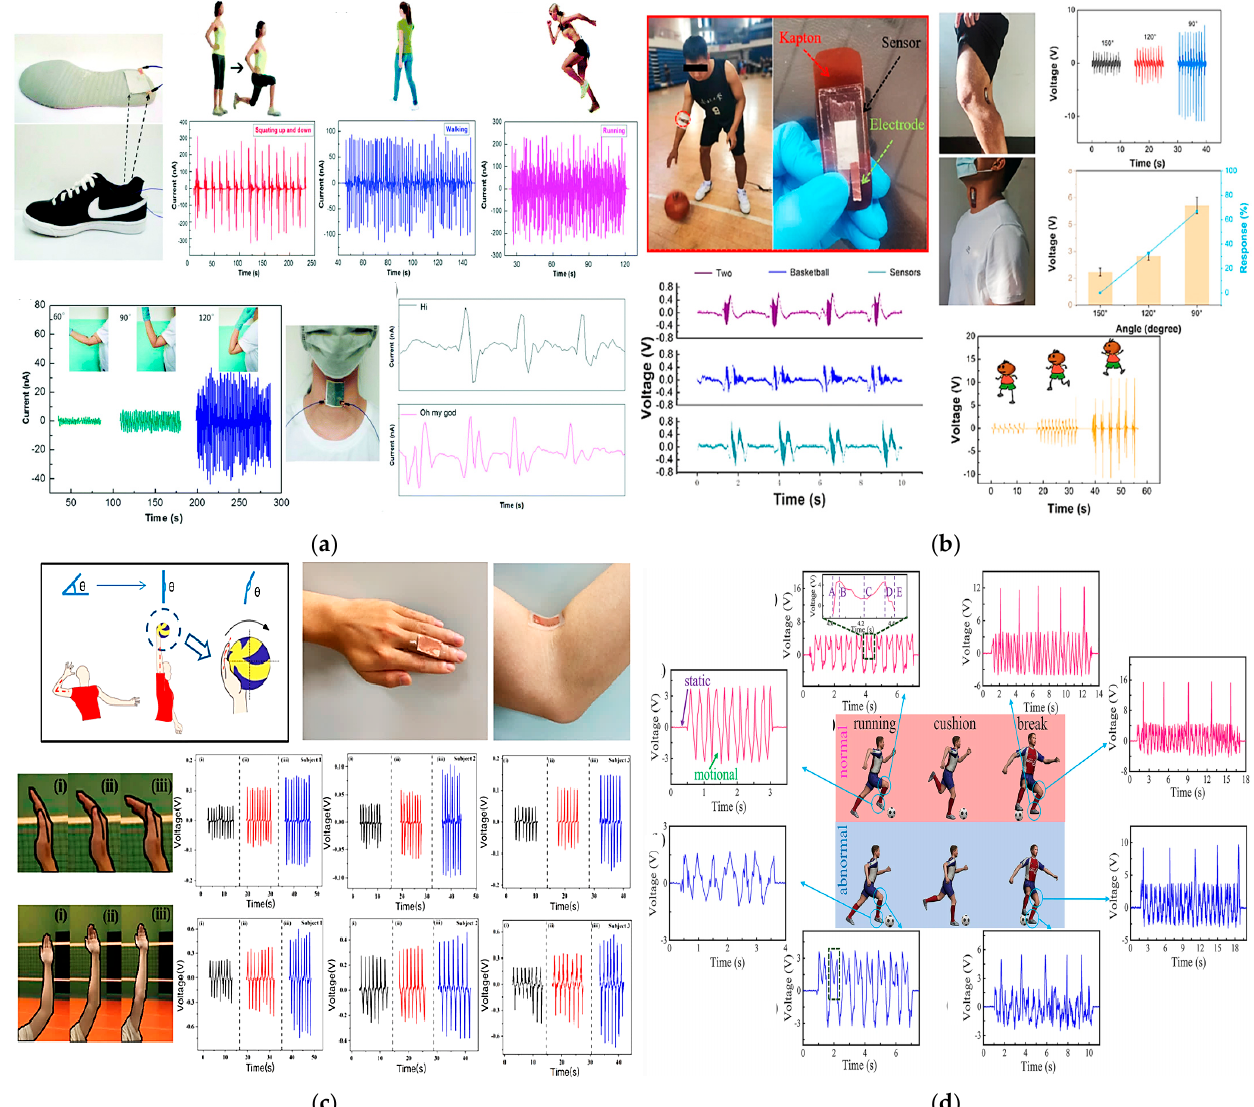
Figure 13. Piezoelectric sensors: PVDF/BaTiO 3 -based sensor integrated into a sole with the corre- sponding output currents generated during squatting, walking, and running activities, elbow ex- tension and flexion to 60°, 90°, and 120°, and the pronunciation of short sentences ( a ) [22]. PVDF/DMF-based sensor applied on an athlete’s elbow and the corresponding voltage signals generated at different bending angles and during different physical activities ( b ) [39]. A schematic dia- gram of different bending angles of the palm during the test of the PVDF sensor. The output piezo- electric voltages of three subjects when finger and elbow bending angle change are also reported ( c ) [42]. Soccer player motion monitoring test using the PVDF–HFP-based sensor ( d ). Pictures of a soc- cer players’ actions, showing normal ankle motion, abnormal ankle motion, normal knee motion, and abnormal knee motion. Moreover, the “brake” action of the same motion is also monitored and reported [64].